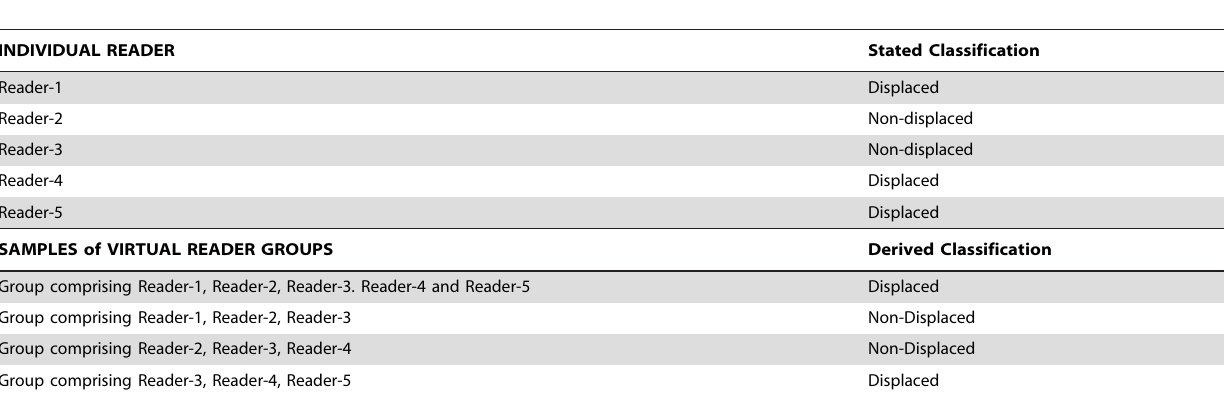
Table 1. A demonstration of the consensus classification of virtual reader groups, as a function of individual classifications on a sample